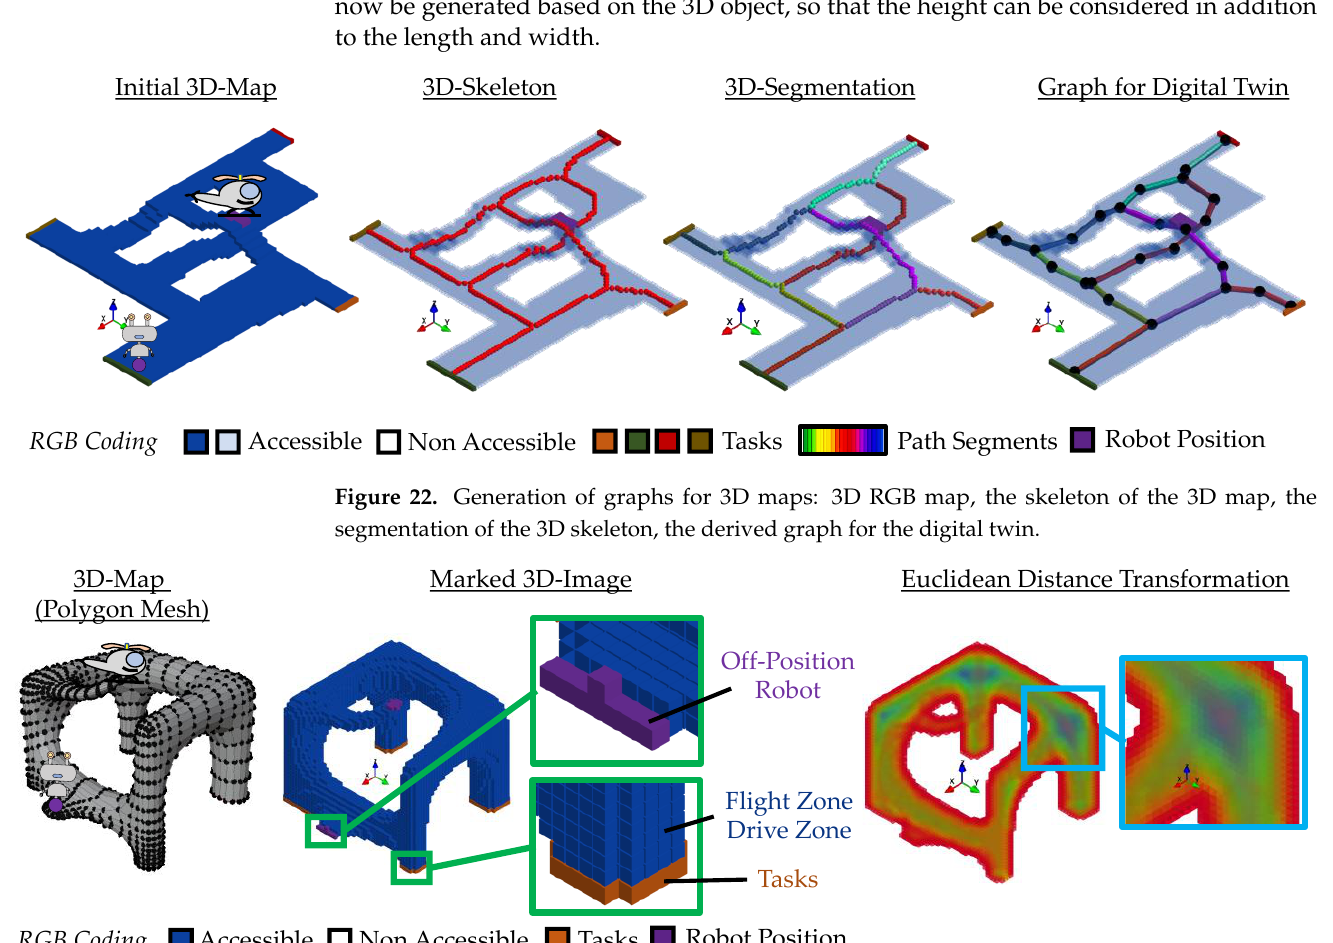
18 of 25 Figure 20. Path generation of a labyrinth: RGB map, path generation without blockade, path generation with blockade, clearance width. The paths including the path widths can be determined automatically. If a path is completely blocked, no path is created. It also can be determined automatically whether a task can be reached at all. The same procedure can be used for a more complicated maze. Figure 21 shows the path definition, the graph for the digital twin and the Euclidean distance transformation of the image for a more complicated maze. Figure 21. Path generation in a complex maze: RGB map, path generation, the graph for digital twin, Euclidean distance transformation.